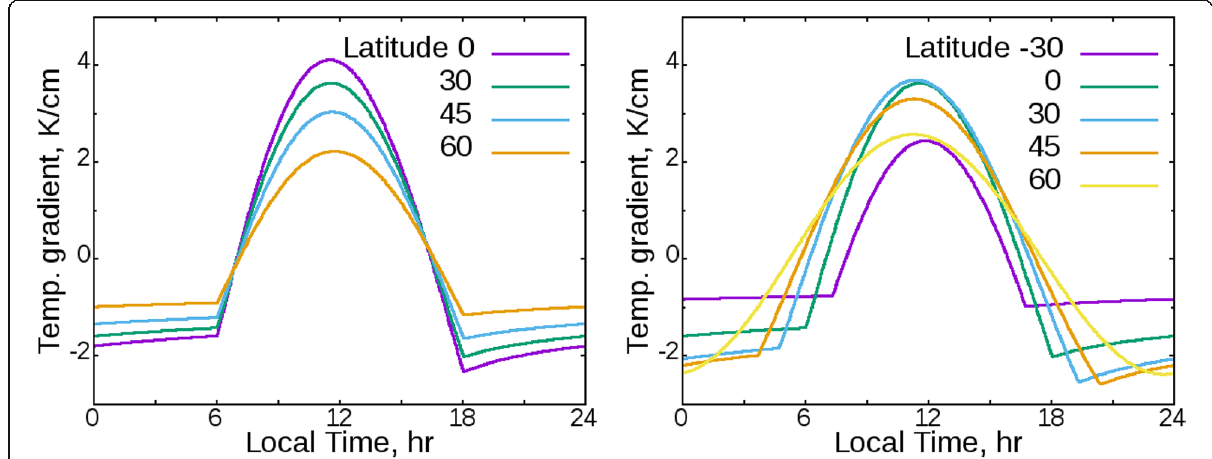
Fig. 10 Thermal gradient just beneath the surface as a function of local time. Left: sub-solar latitude of 0°. Right: sub-solar latitude of 30°. The negative maximum of the thermal gradient is achieved at sunset while the positive maximum of the thermal gradient is achieved just before